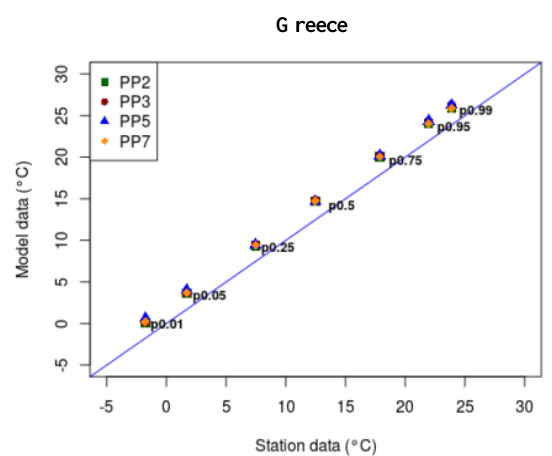
Figure 10. Percentiles of daily minimum temperatures for the four WRF simulations vs. observational percentiles for some indicative stations and their average for region of Greece (D02). Straight line represents the perfect performance.